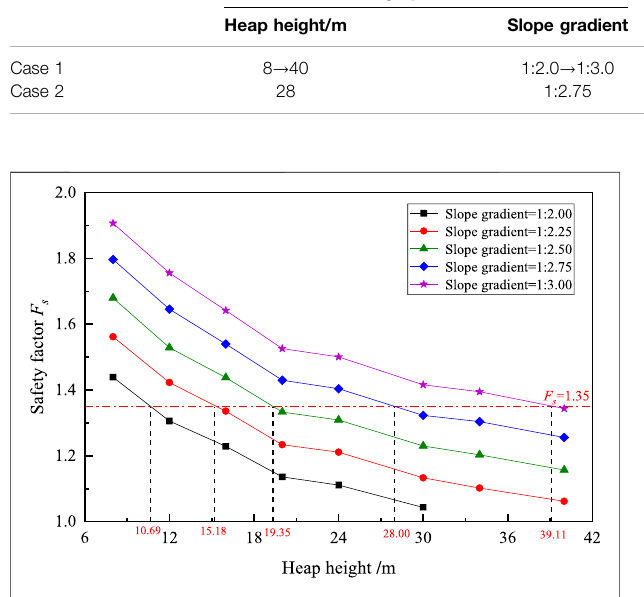
FIGURE 3 | Variation of safety factor with heap height under different slope